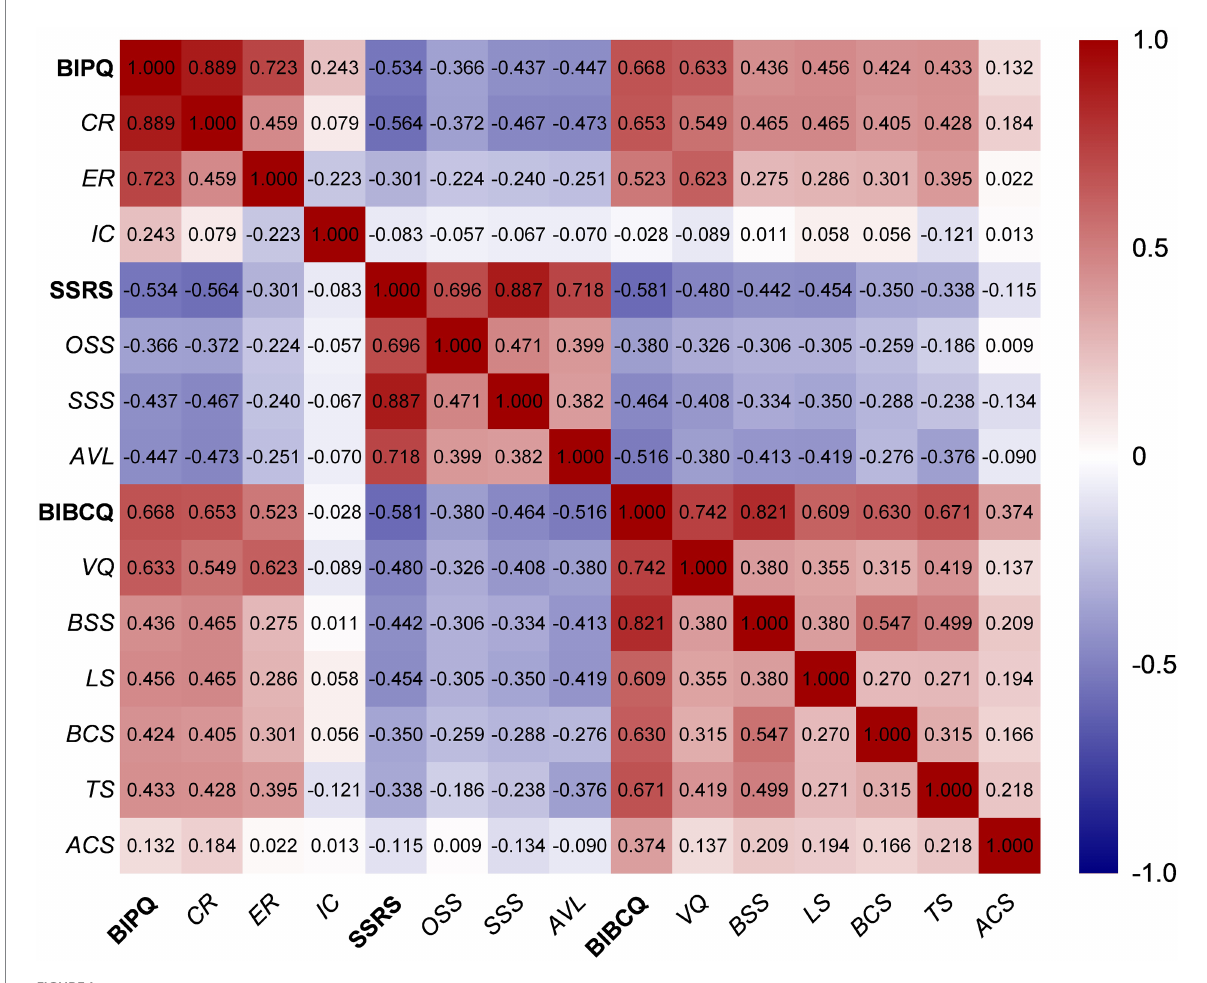
FIGURE 1 Heatmap of Pearson correlations in BIPQ, SSRS and BIBCQ. Figure represents the coefficients of the correlation analysis of illness perception, social support, and body image cognition. BIPQ, the brief illness perception questionnaire; CR, cognitive representation; ER, emotional representation; IC, illness comprehensibility; SSRS, social support rating scale; OSS, objective social support; AVL, availability; BIBCQ, the body image after the breast cancer questionnaire; VQ, vulnerability scale; BSS, body stigma scale; LS, limitation scale; BCS, body concerns scale; TS, transparency scale; ACS, arm concerns